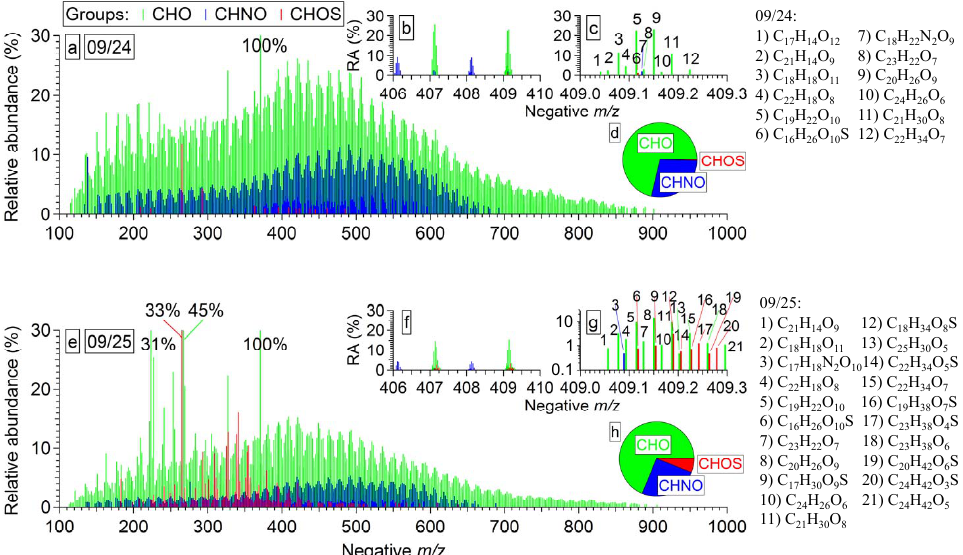
Figure 5. Reconstructed mass spectra of the assigned monoisotopic ions for PMO WSOM on 9 / 24 (a–d) and 9 / 25 (e–h) with CHO, CHNO and CHOS groups of compounds. Number fractions of detected monoisotopic formula assignments in all groups are given as the pie charts in (d) and (h) . An illustration of the isobaric complexity is shown as an excerpt of mass spectra in the ranges of m/z 406—410 ( b and f ) and m/z 409.0–409.3 ( c and g ). All identified molecular formulas between m/z 409.0 and 409.3 are listed in the order of